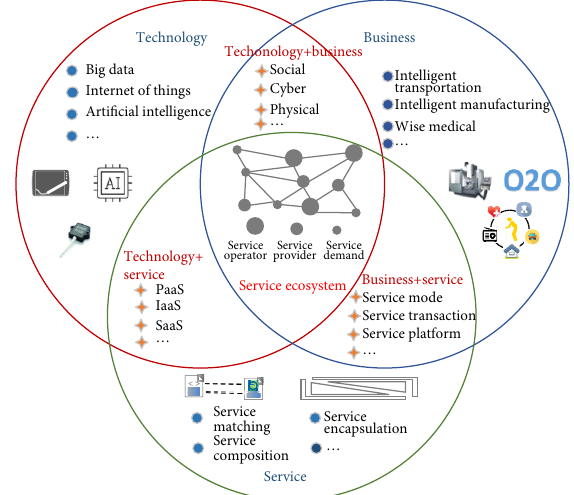
Fig. 3 Service ecosystem relation